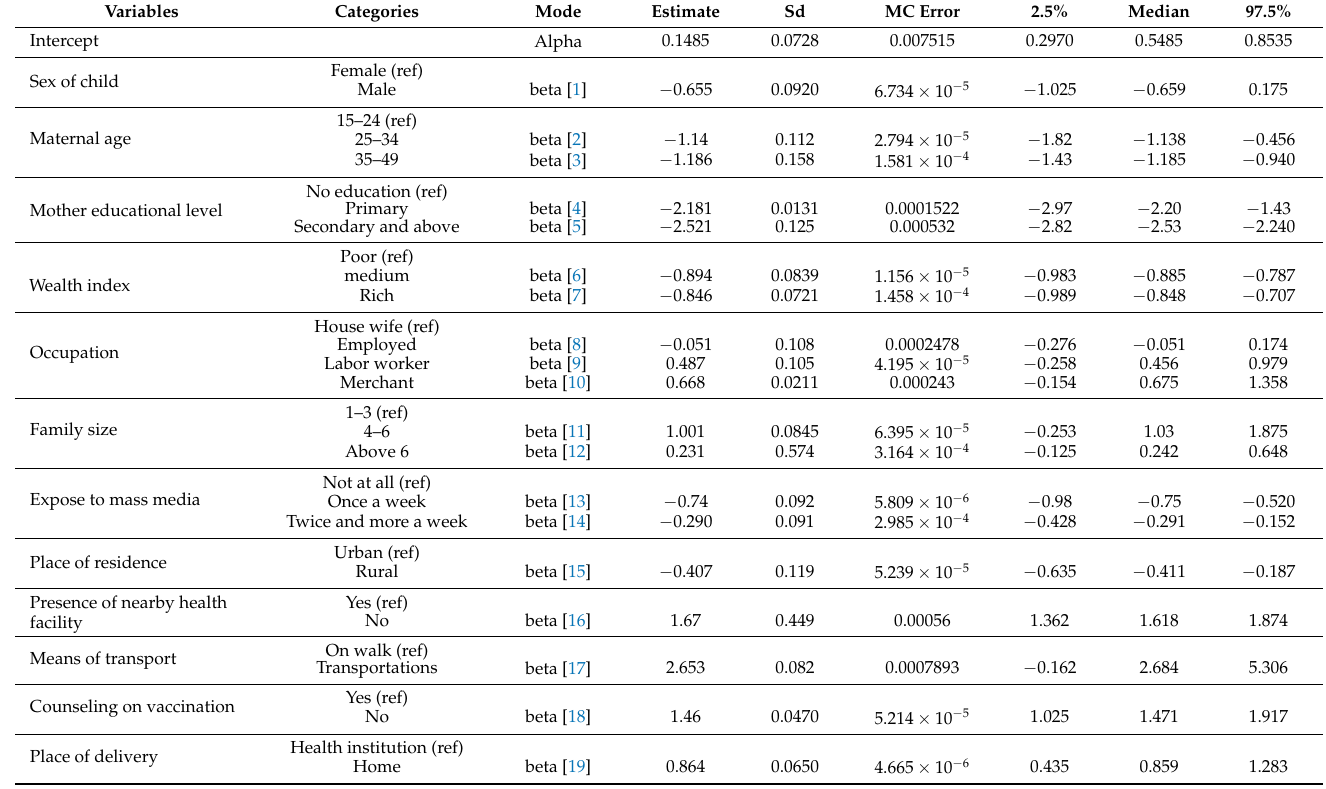
Table 3. Results of Bayesian binary logistic regression